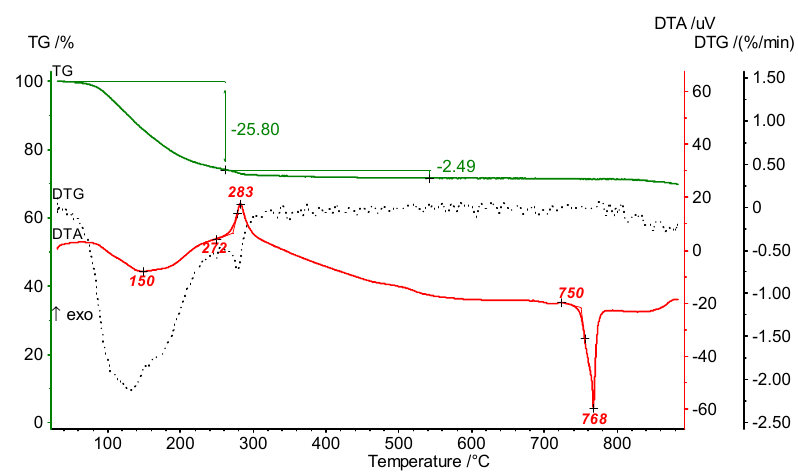
Figure 13. TG/DTA heating curves of LiMgAlF 6 .